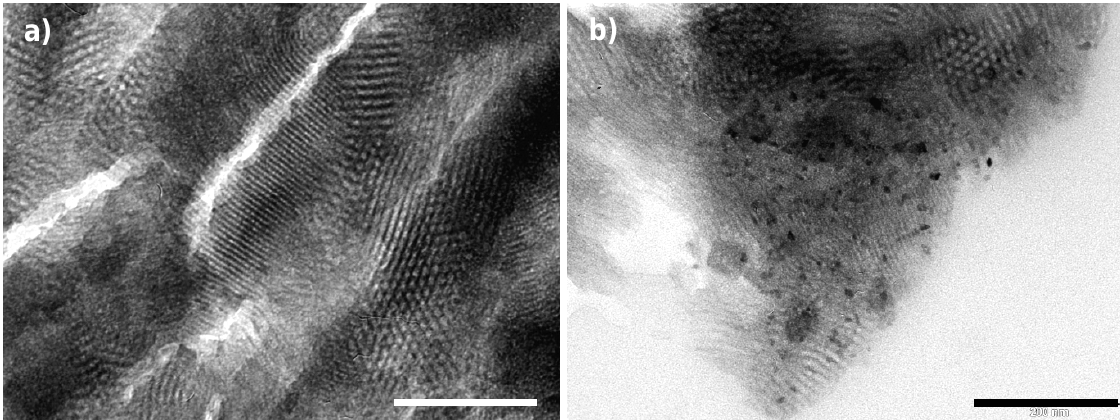
Figure 13. ( a ) TEM image of the thermally treated Co(II)-containing silica film. (microtomed sample); ( b ) TEM image of RbCoFe PBA/silica film nanocomposite (microtomed sample). Scale bar is 200